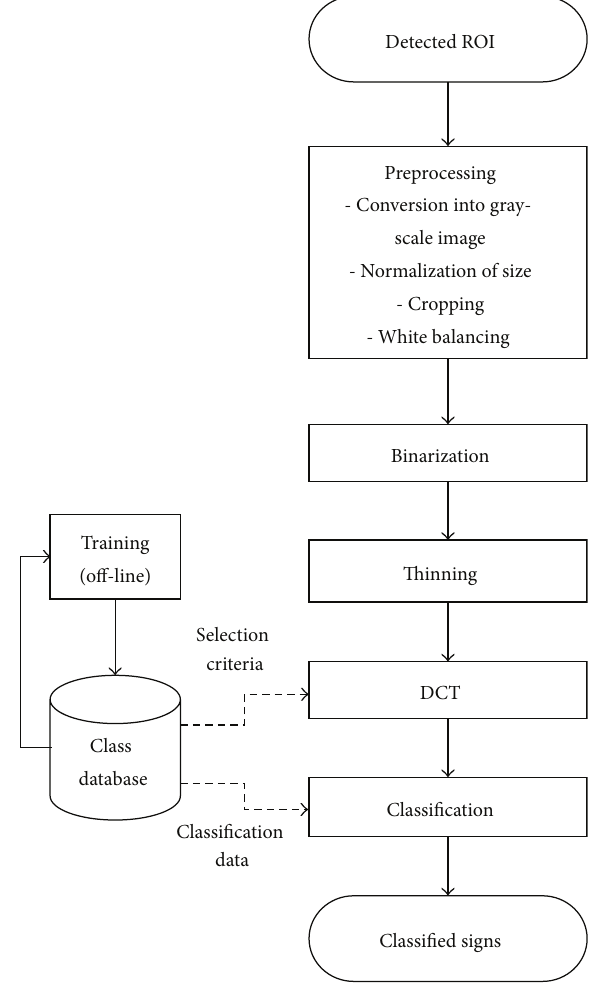
Figure 2: Flowchart of the proposed